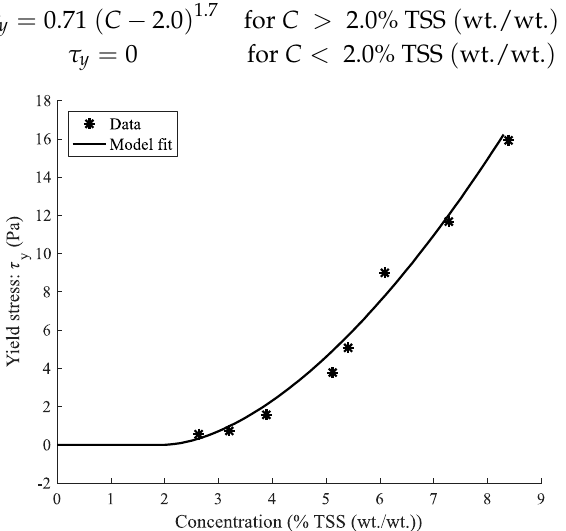
Figure 6. Influence of change in concentration of % total suspended solids (TSS) to Yield stress τ y of concentrated domestic slurries (CDS).